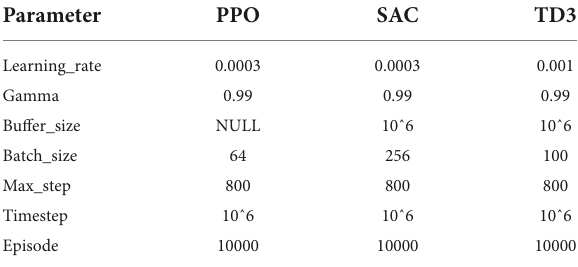
TABLE 1 Parameter table of deep reinforcement learning algorithm.